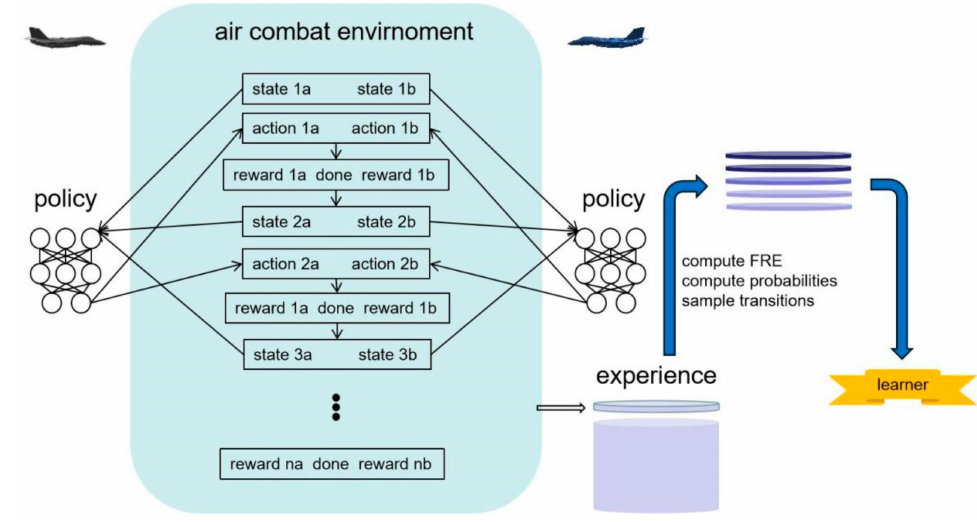
Figure 1. FRE-PPO Self-Play Architecture.